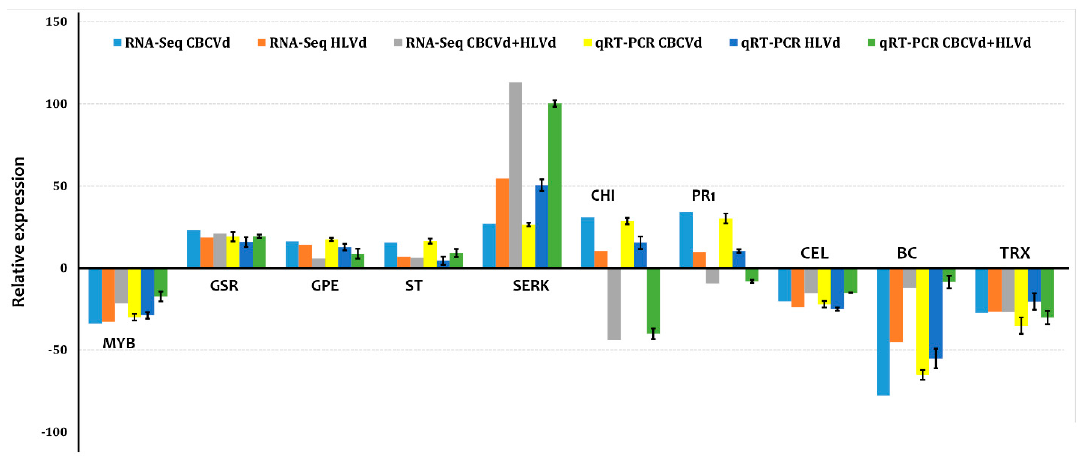
Figure3. Validationofdi ff Figure 3. Validation of differentially expressed genes from RNA sequencing by RT-qPCR. Graph showing fold change of genes in a leaf of CBCVd infected HLVd infected, and HLVd-CBCVd